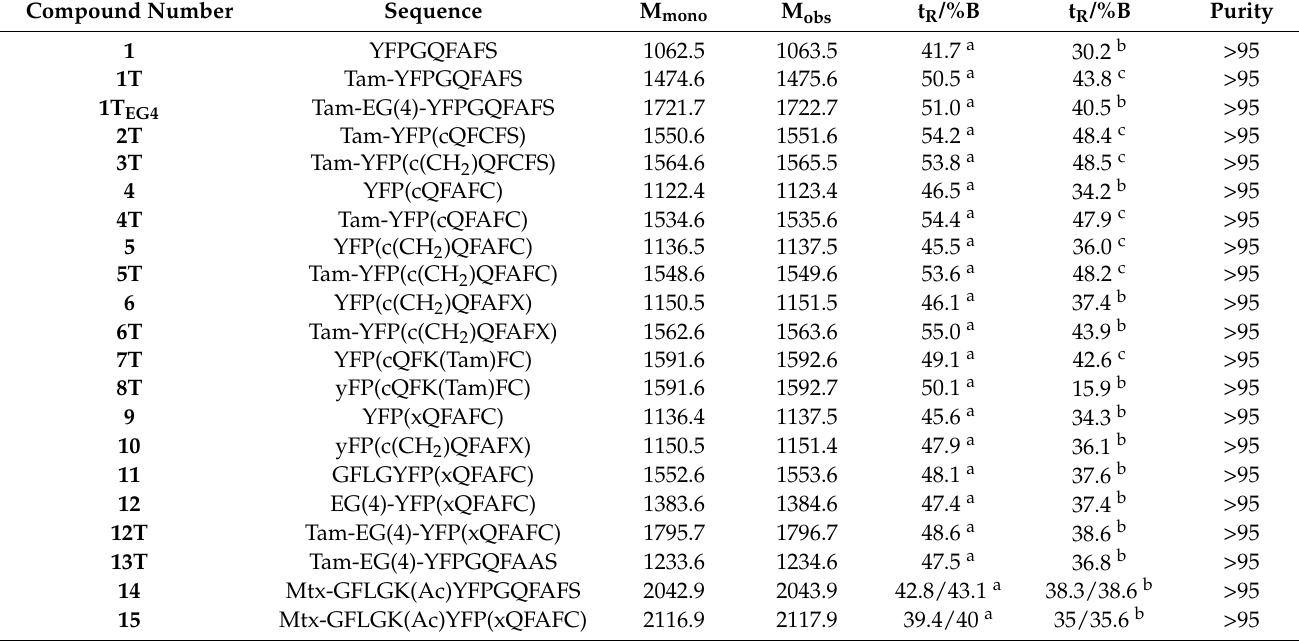
Table 3. Analytical data of the investigated peptides. Square brackets indicate sites of cyclization by disulfide bonds or thioacetals. Methyl groups in the sequence indicate a thioacetal between the two side-chain sulfur atoms in the respective